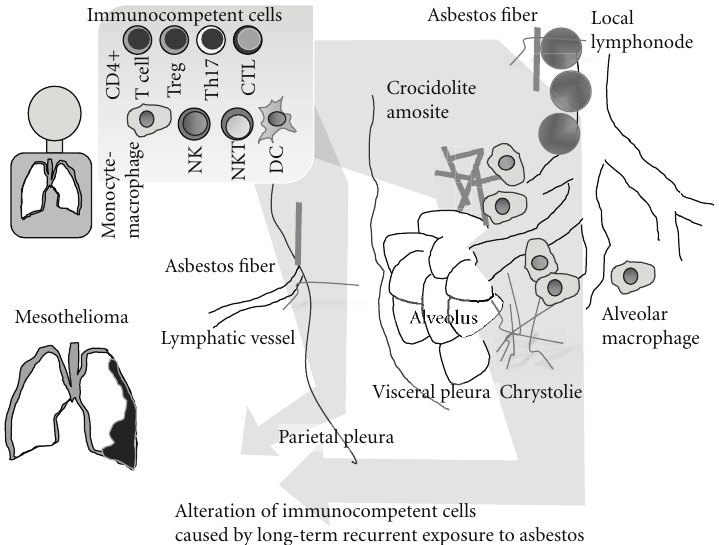
Figure 1: Localization of inhaled asbestos fibers in the lung, pleural cavity, and regional lymphonodes. Chronic and recurrent encounters between circulating immunocompetent cells and these moored asbestos fibers causing the long-term alteration of these